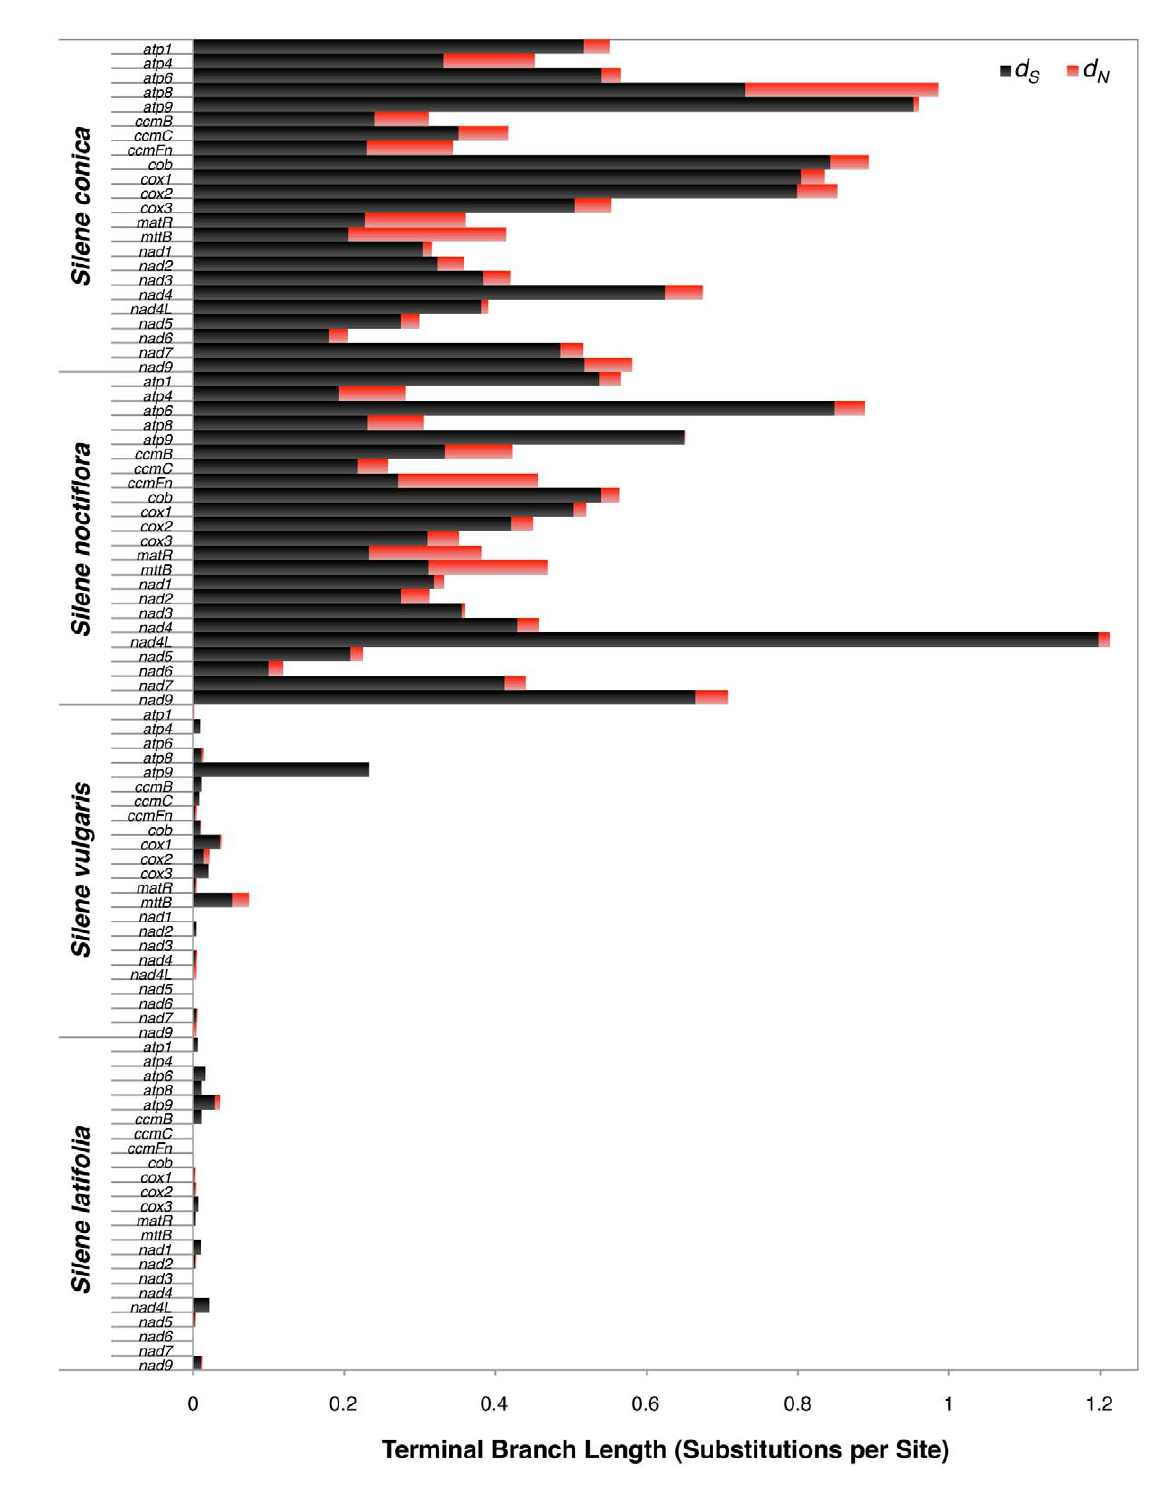
Figure 2. Levels of synonymous ( d S ) and nonsynonymous ( d N ) sequence divergence in terms of substitutions per site for protein genes in Silene mitochondrial genomes. Estimates were generated using B. vulgaris and A. thaliana as outgroups.